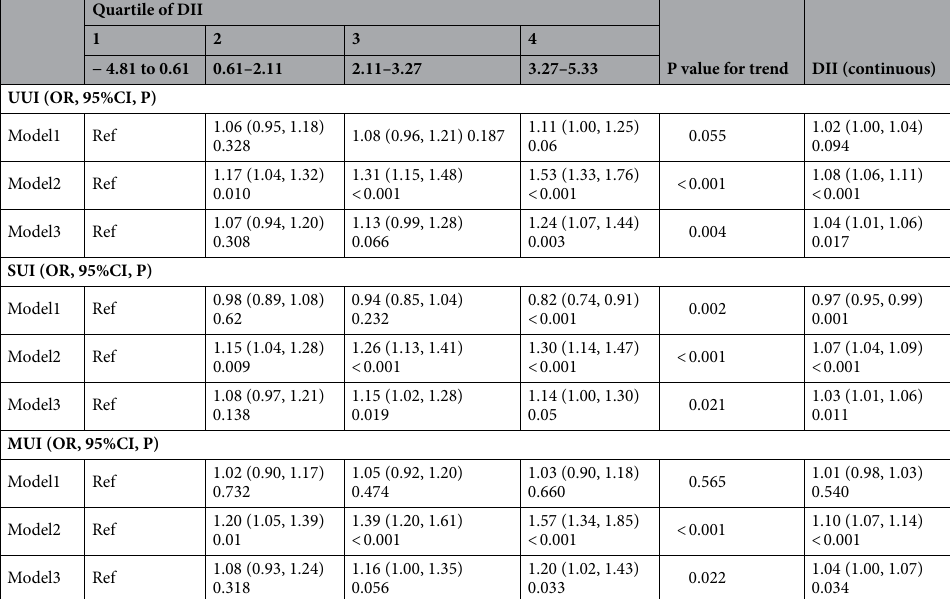
Table 1. Relationship between DII and urinary incontinence in the unadjusted, minimally adjusted and fully adjusted logistic regression models. Model1: adjust for: None. Model2: adjust for: age (Smooth); Race; Energy (Smooth). Model3: adjust for: age (Smooth); Race; Energy (Smooth); BMI; menopause; alcohol intake per week; CAD score; physical activity; least 100 cigarettes; Ratio of family income to poverty; education; Marital; deliveries (Smooth). DII, dietary inflammatory index; UUI, Urge Urinary Incontinence; SUI, stress urinary incontinence; MUI, mixed urinary incontinence; CI, confidence interval; Ref, Reference; OR, odds